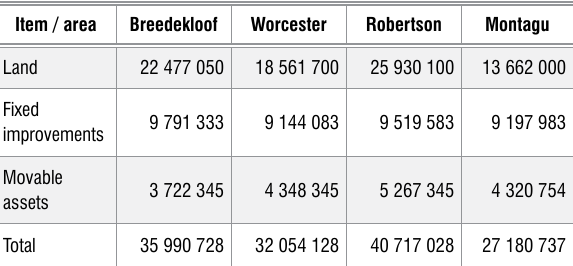
and allocated variable cost. For this cultivar the expected gross margin stabilises at ZAR50 198 for the remainder of the expected life of the vineyard over 20 years.